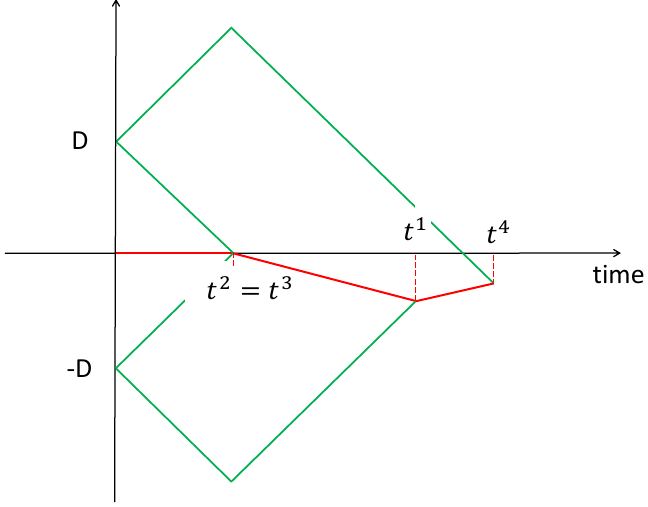
Figure 3. Optimal strategy for v ∈ [ 0.001,0.618 ]